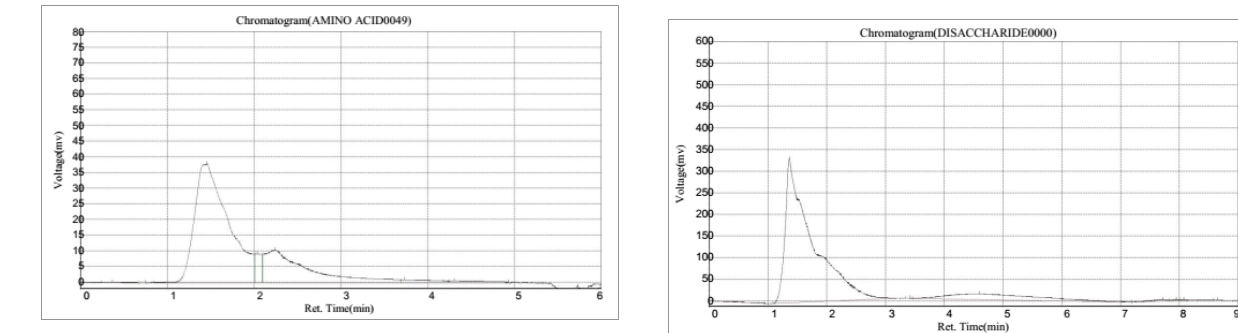
High-performance liquid chromatogram of tiger nut amino acids.